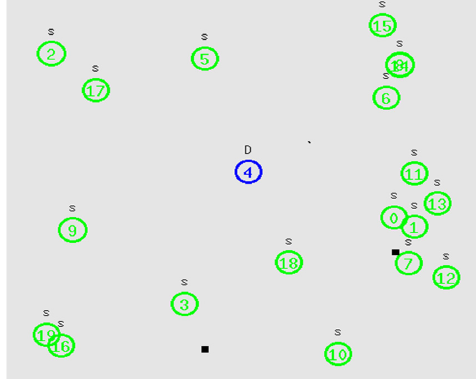
Figure 9. Network simulation 2 NS2 simulation.